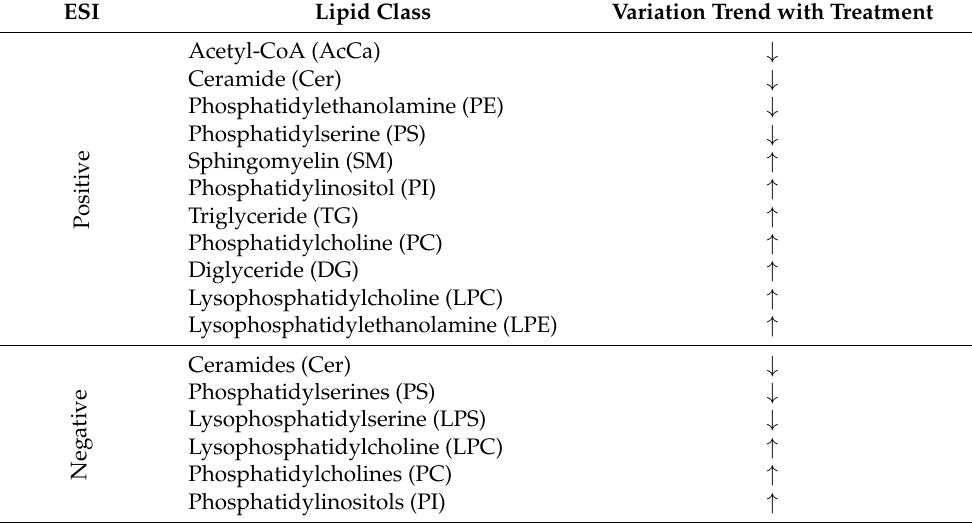
Table 2. Variation trends for lipid classes induced by the maceration process based on t -test results between fresh and macerated samples without considering different protocols ( ↓ = decreasing trend; ↑ = increasing